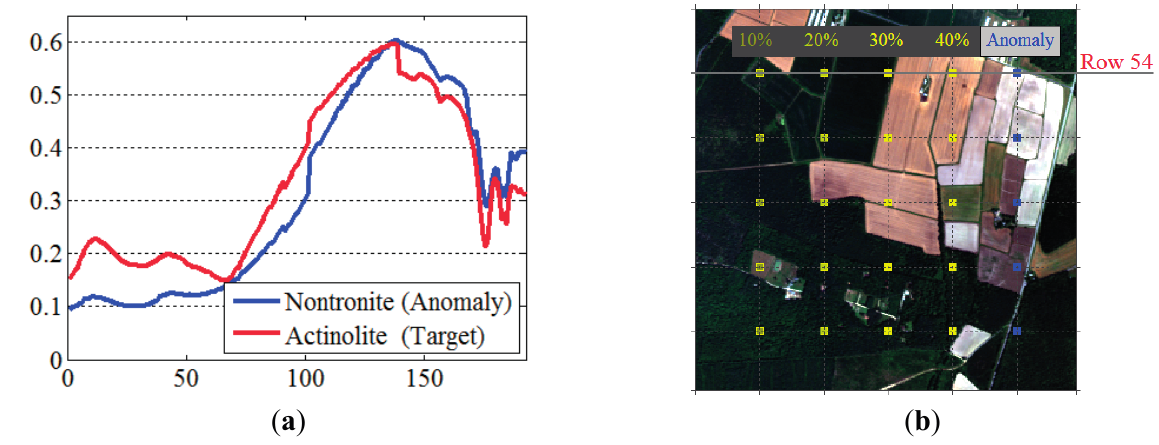
Figure 10. ( a ) Implanted target and anomaly spectral signatures. ( b ) Implanted target and anomaly locations.